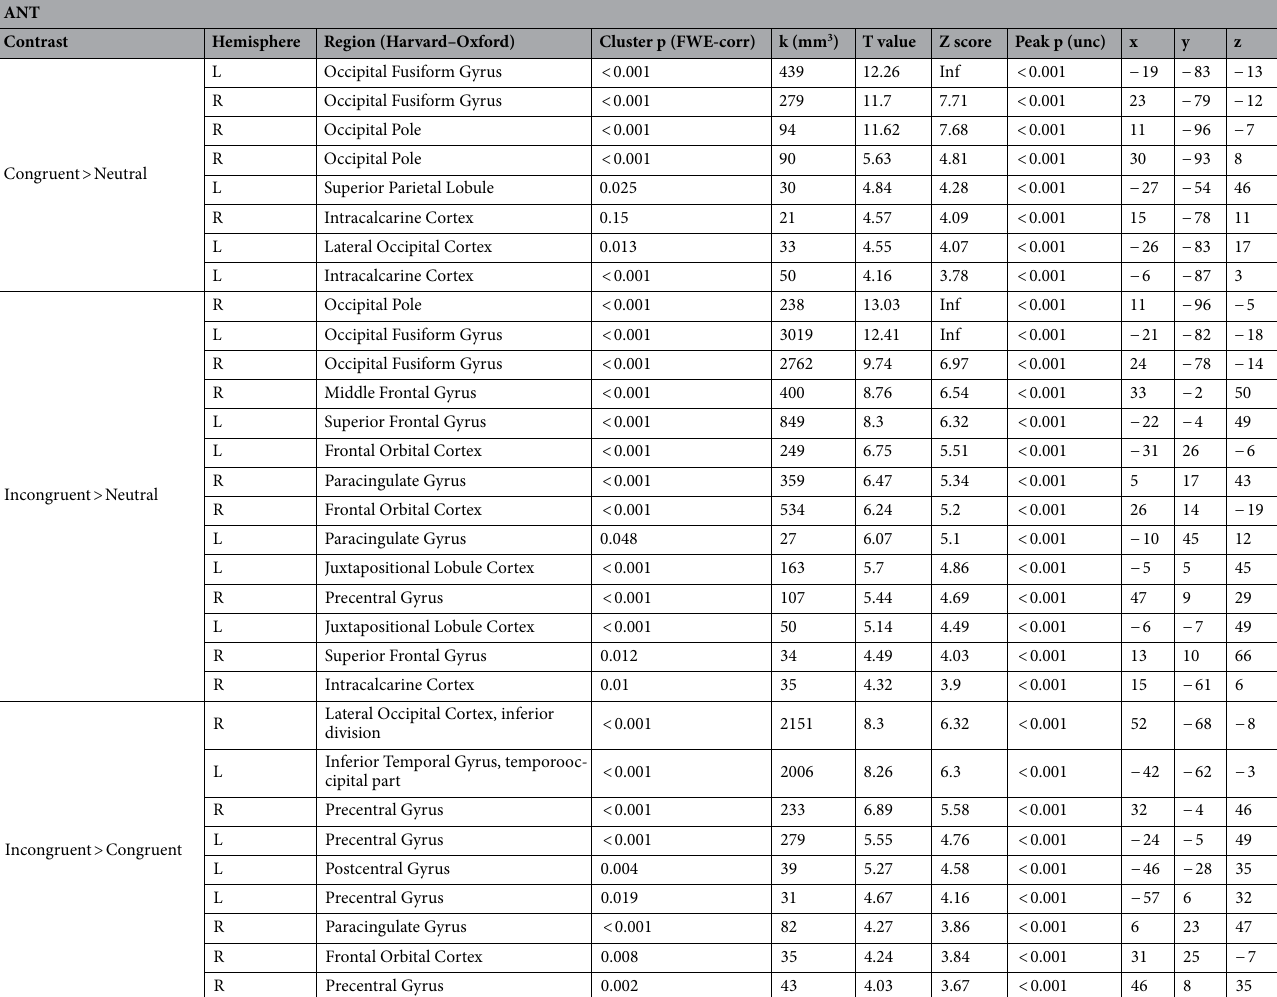
Table 1. t-contrast results for the effects detected in the ANT task. Significance threshold is set at vertex-p- uncorrected < 0.001 and cluster-p-FWE-corrected < 0.05. Only one local maximum per significant cluster is listed. R Right hemisphere, L Left